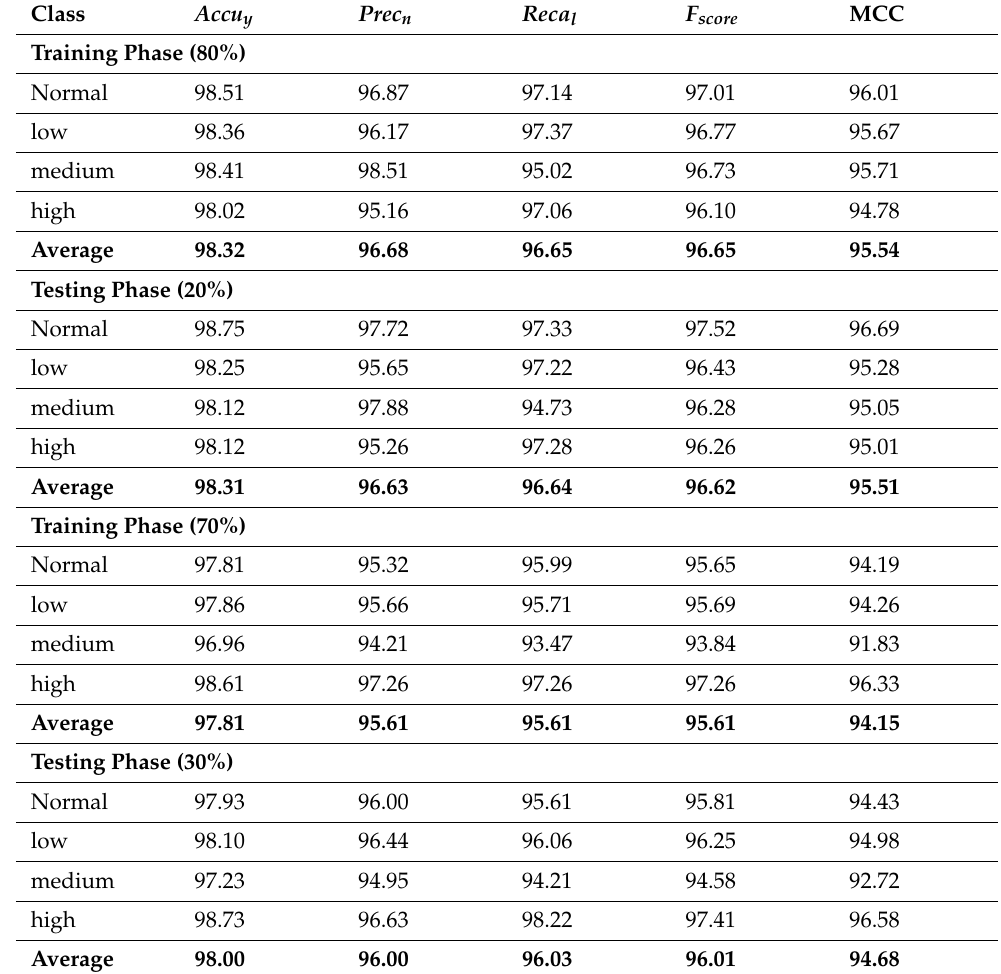
Table 5. Accident severity classification outcome of the PPIE-ODLASC approach with varying measures. Class